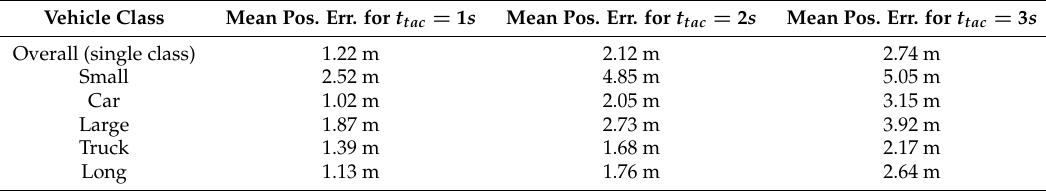
Table 3. Taking vehicle type into consideration for state prediction in tactical timeframe in comparison to considering all vehicle types as a single